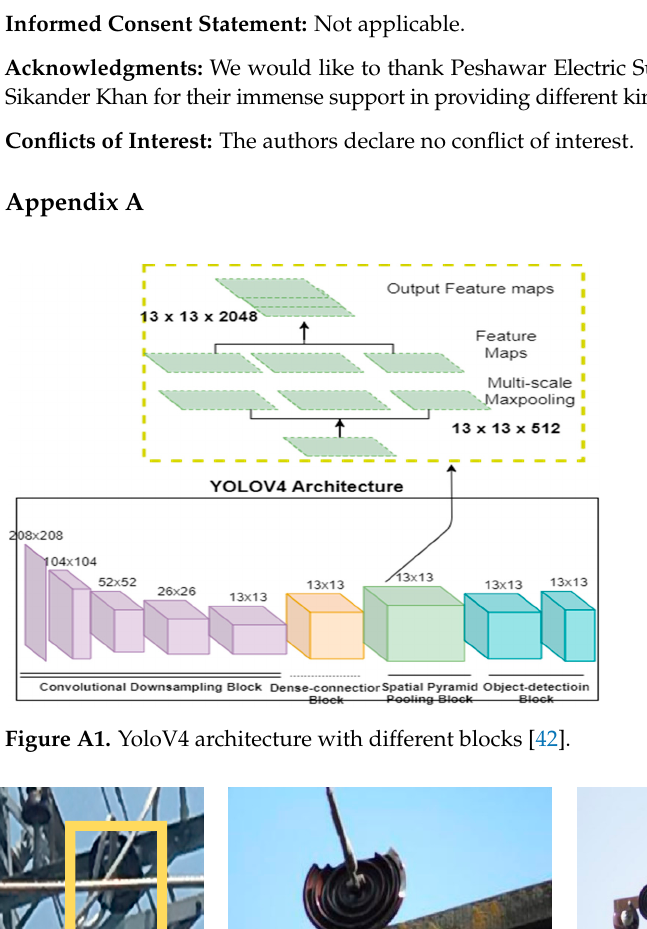
( f ) Figure A3. Test dataset ( a ), complex (C) ( b ), low light (R-1) ( c ), aerial image with better visibility ( d ), Prototype-C ( e ), Prototype-S, ( f ) variants of a low-light image with LIME. Figure A4. Test results. Row 1, left: YoloV4. Row 1, right: YoloV5x. Row 2, left: YoloV4 Tiny. Row 2, right: YoloV5s.